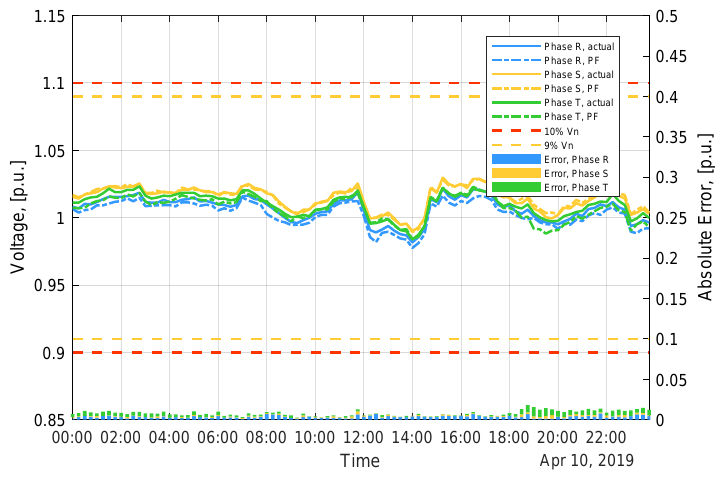
Figure 9. Model validation. Voltage profiles—Summer day.